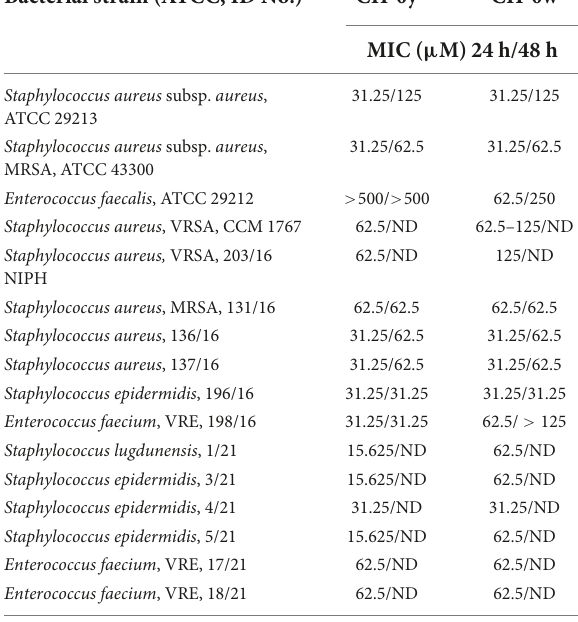
TABLE 1 Antibacterial activity of CH-0y and CH-0w against reference strains and clinical isolates of the genus Staphylococcus and Enterococcus